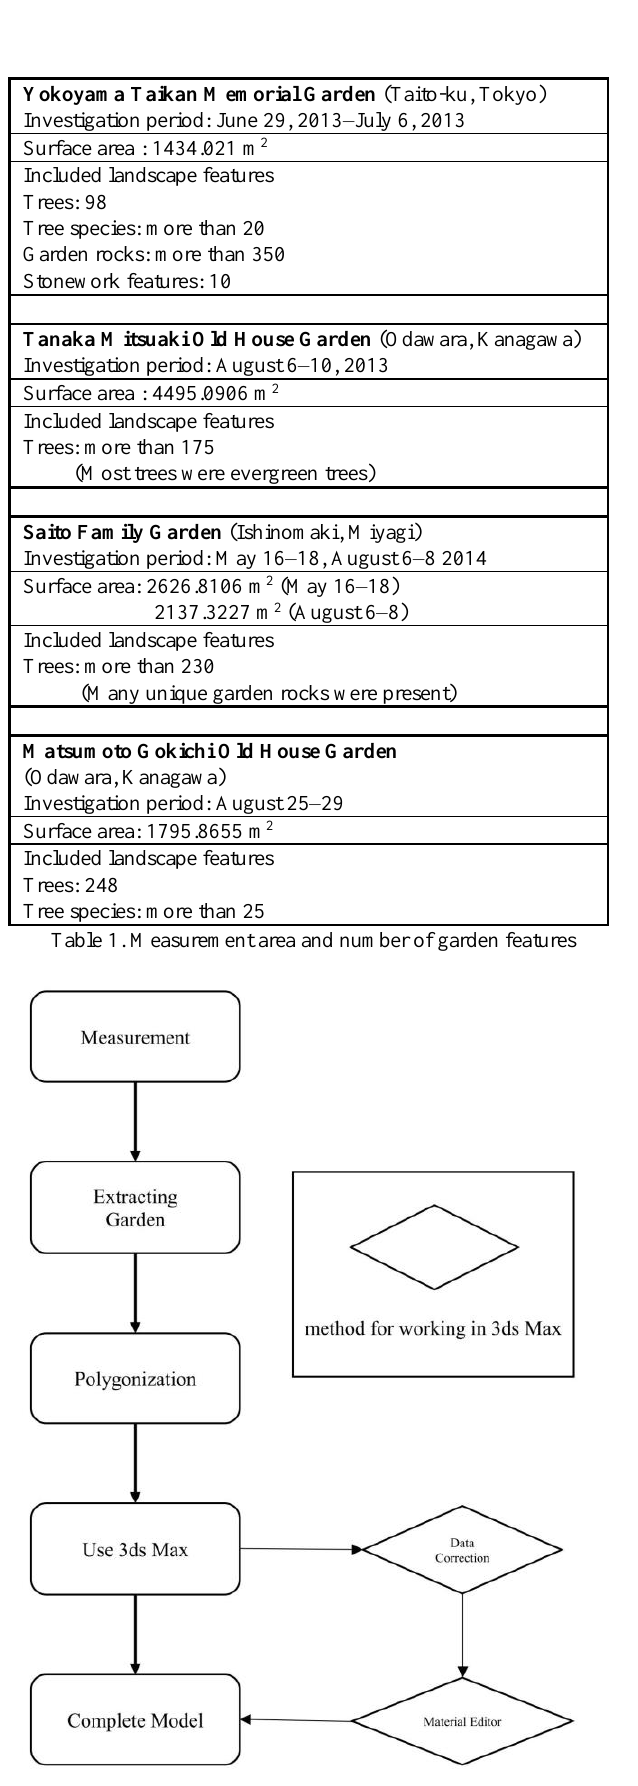
Figure 1. Tree cutting simulation at Odawara Castle Figure 2. Flowchart of production process for tree